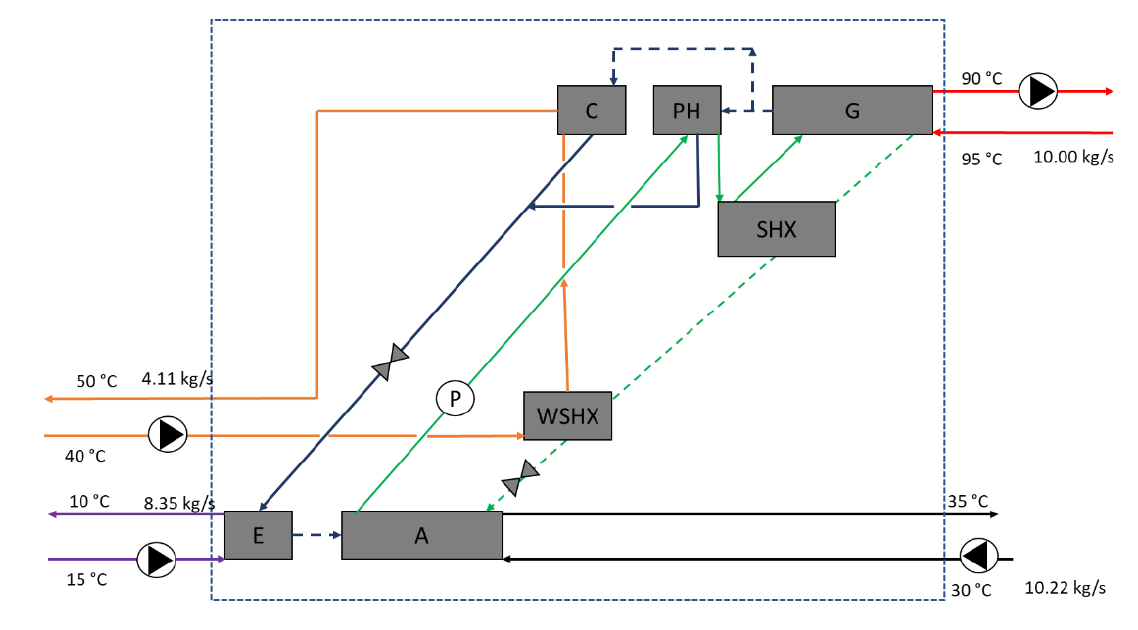
Figure 12. Working temperatures and flow rates for the simultaneous heating and cooling for air conditioning applications. Table 3. Absorption heat pump performance for air conditioning application.